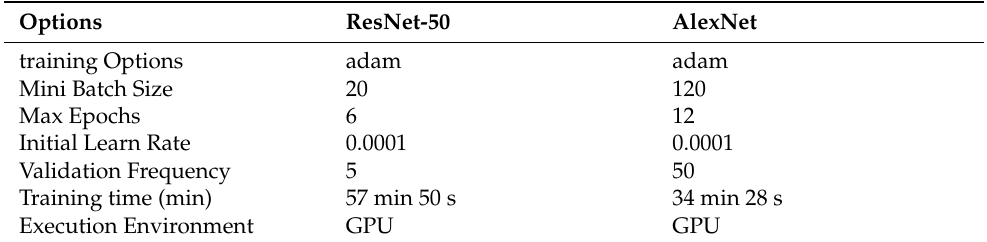
Table 5. Training parameter options for the ResNet-50 and AlexNet models.